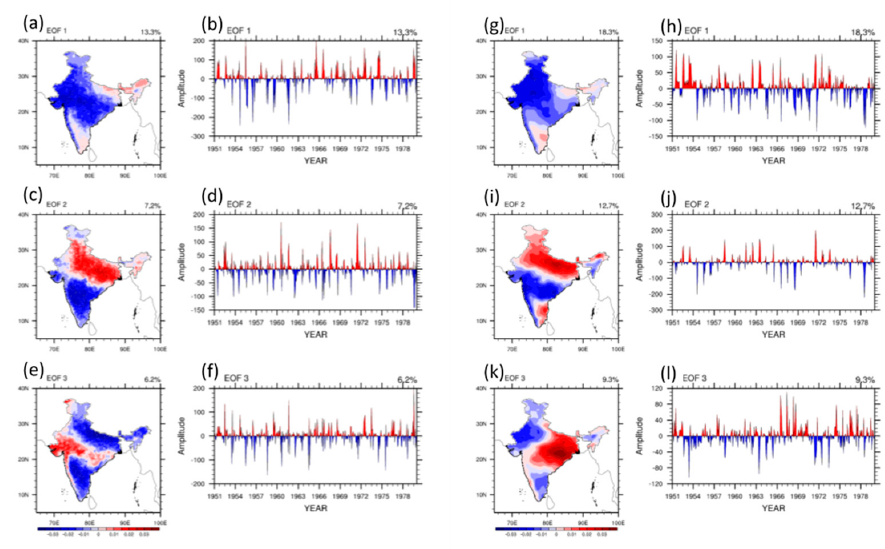
Figure 4. First three EOFs and their corresponding PCs of the precipitation for the period 1951–1980 from ( a – f ) AGCM ensemble and ( g – l ) IMD observation.